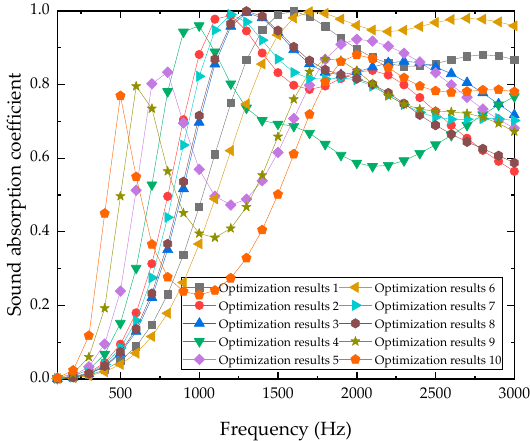
Figure 12. Optimized results (optimization goals are unconstrained).